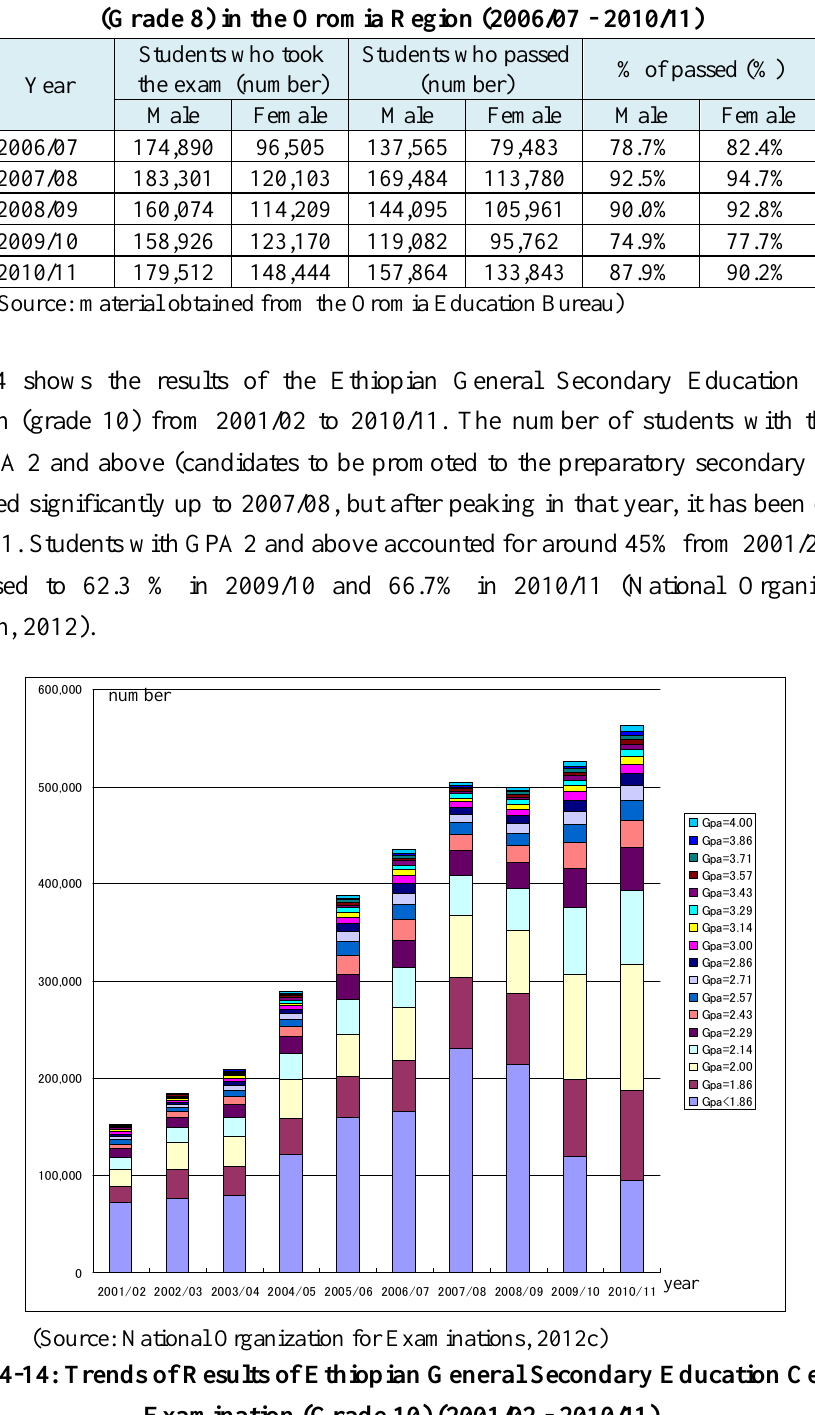
Table 4-12: Number of Students Taking Primary School Leaving Certificate Examination